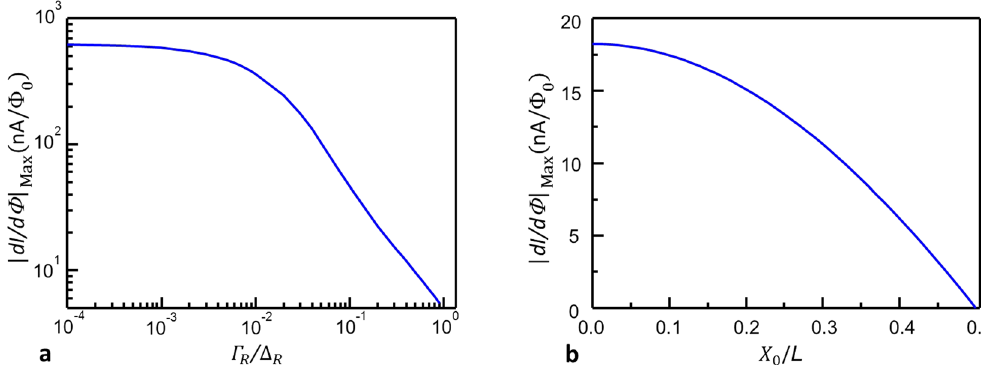
Figure 6. Theoretical prediction of the parameters impact on interferometers performance. ( a ) Maximum absolute value of the flux-to-current transfer function (| dI / d Φ | Max ) versus normalized Dynes parameters of the ring. ( b ) Maximum absolute value of the flux-to-current transfer function (| dI / d Φ | Max ) versus the probe position respect to the middle of the Methods Device fabrication details.